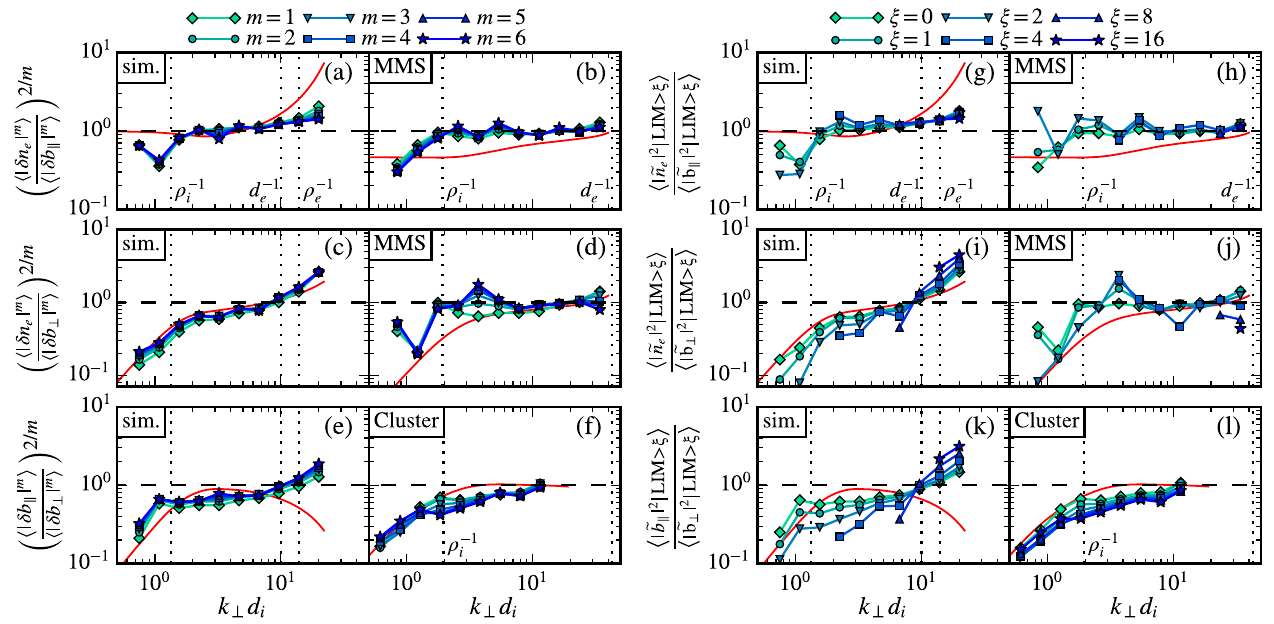
FIG. 7. Generalized spectral field ratios obtained from Cluster and MMS measurements and from the 3D fully kinetic simulation (see text for further details). Panels (a) – (f) show the moment ratios [Eq. (12)] and panels (g) – (l) show the conditional ratios [Eq.